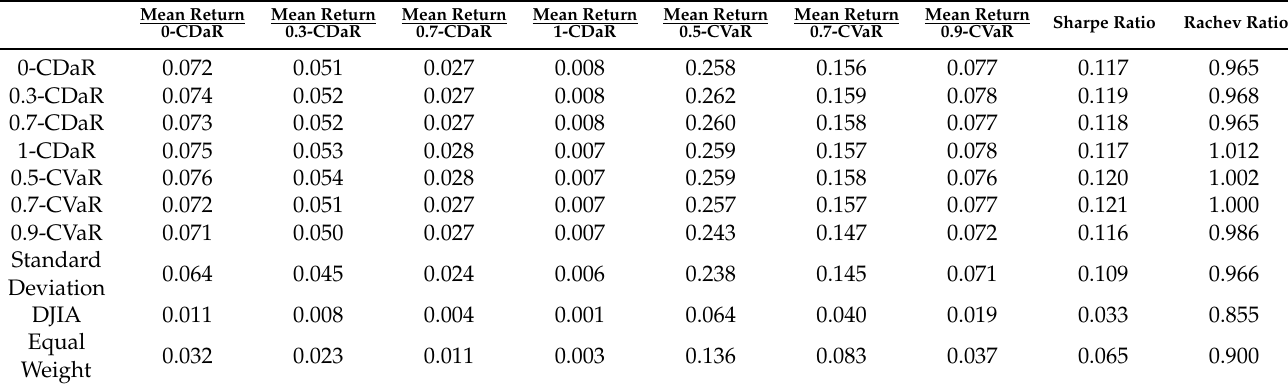
Table 4. Performance ratios of optimal portfolios with different risk